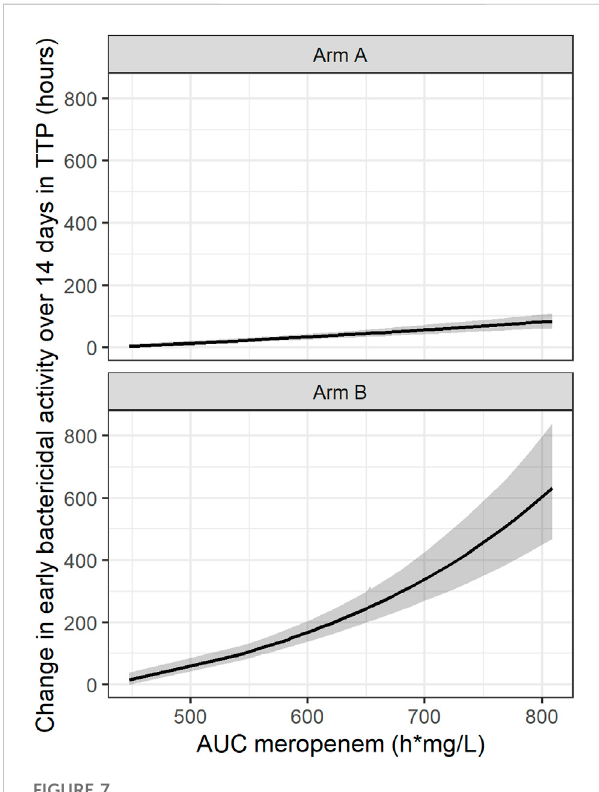
FIGURE 7 Established pharmacokinetic-pharmacodynamic (PK-PD) relationship between area under the curve (AUC) of meropenem and early bactericidal activity (EBA) based on time-to-positivity of 0 – 14 days (TTP-EBA 0-14 ) for the typical individual with one or several cavities < 4 cm. The black line represents the median and the shaded area represents the 95% con fi dence interval. 95% con fi dence interval is derived from Sampling Importance Resampling (SIR) method followed by Stochastic Simulation and Estimation (SSE) step of 1,000 samples. Arm A resembling meropenem in 2 g meropenem thrice daily with 500 mg amoxicillin and 125 mg clavulanate thrice daily on days 1 – 14 (De Jager et al., 2022). Arm B